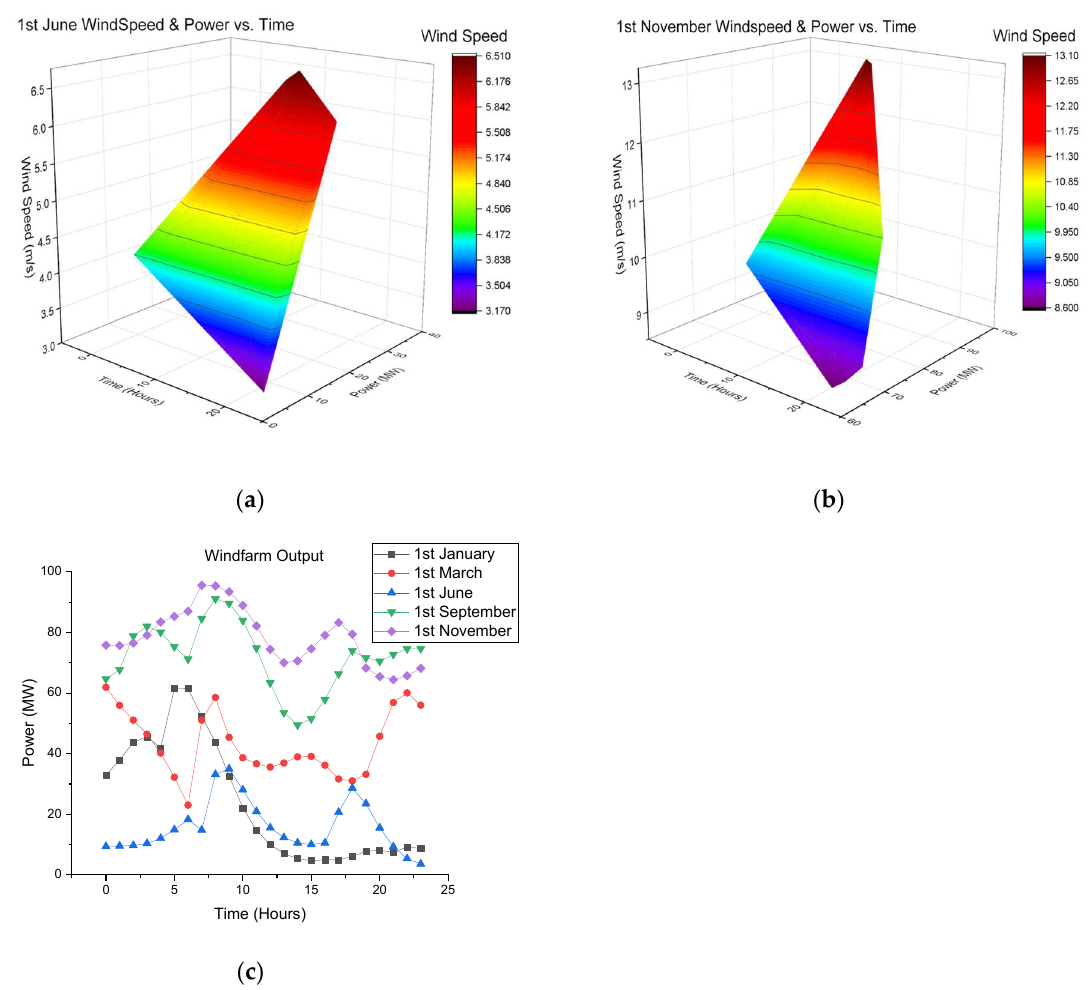
Figure 17. ( a ) June 3D wind speed and power vs. time. ( b ) November 3D wind speed and power vs. time. ( c ) Daily seasonal wind farm output.